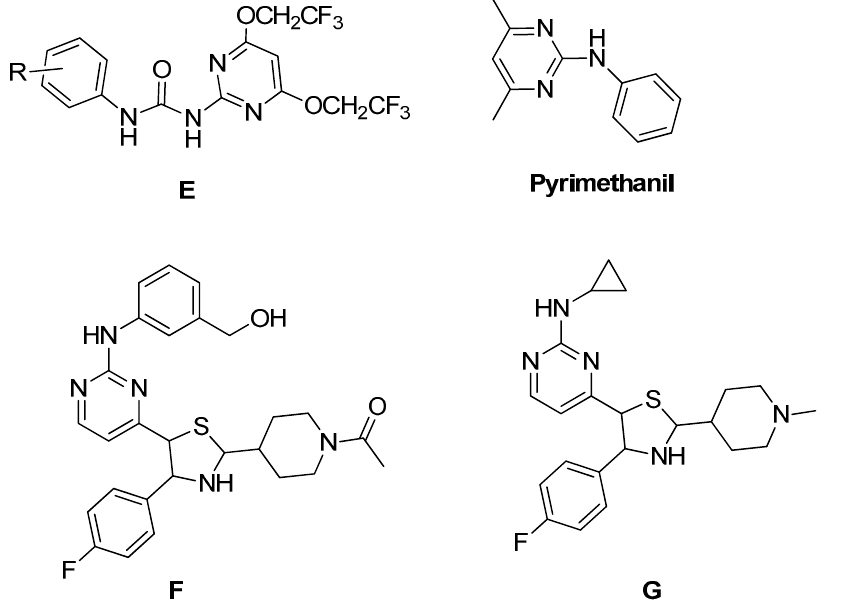
Figure 2. Chemical structures of compounds with pyrimidine groups.